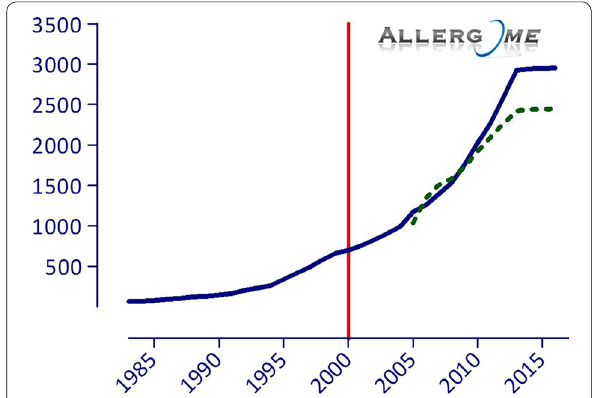
Fig. 1 Scientific publications in molecular allergology in the last